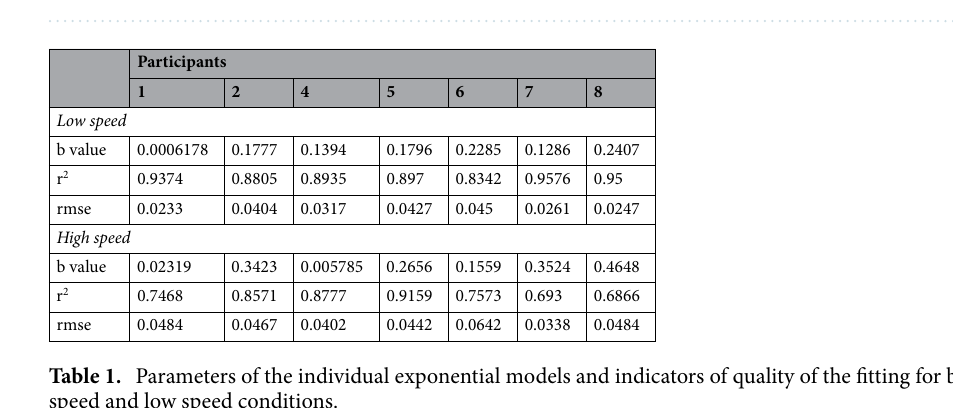
Figure 1. Performance improvement. ( A ) Stroke frequency during session 1 (pre-test) and session 16 (post- test) for both speed condition; ( B ) Exponential model presenting the individual rate of learning in the high- speed condition (black continuous line) and low-speed condition (red dashed line). ( C ) Exponential parameter values showing the interindividual variability in the rate of learning between high speed and low speed conditions.